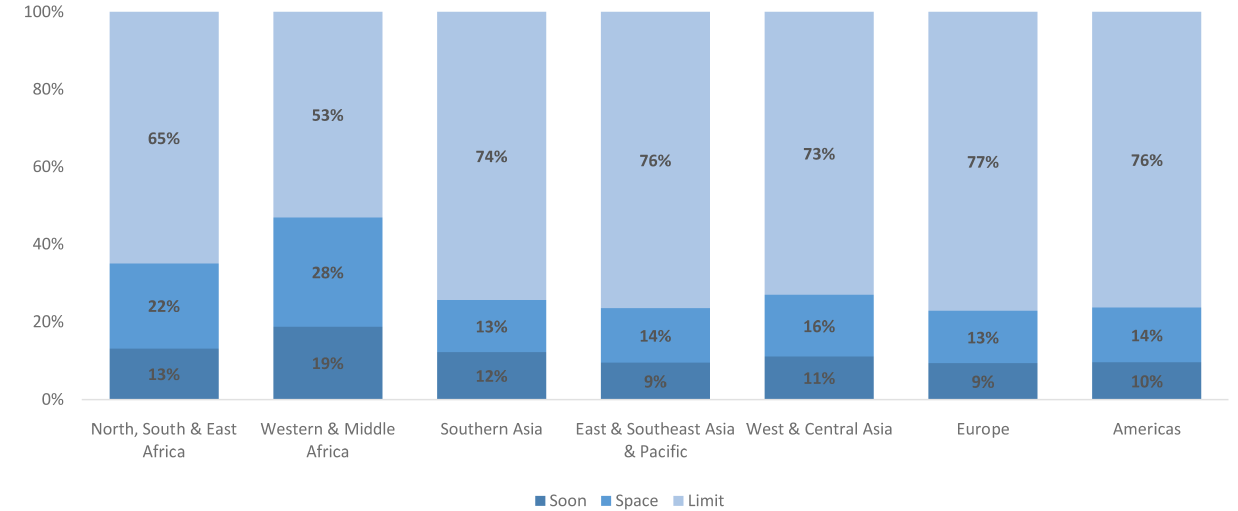
Figure 6. Distribution of married women by market segment and region in 2040. This figure shows the distribution of married women across the three married segments in 2040 by region. In all regions, married women wanting no more children (limit) make up the largest share, though the relative size of this segment varies.